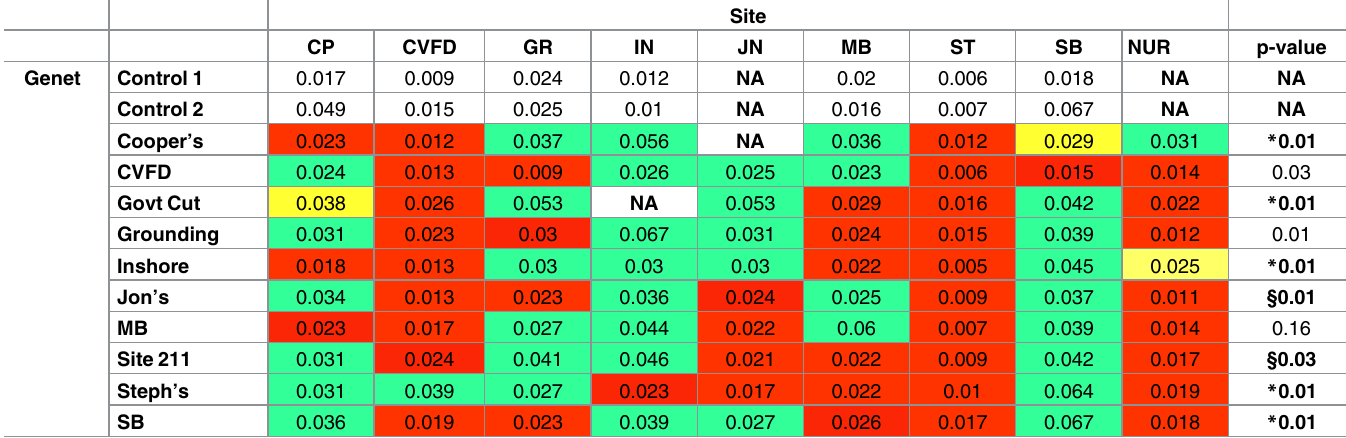
Table 2. Growth of specific genotype x environment combinations for each